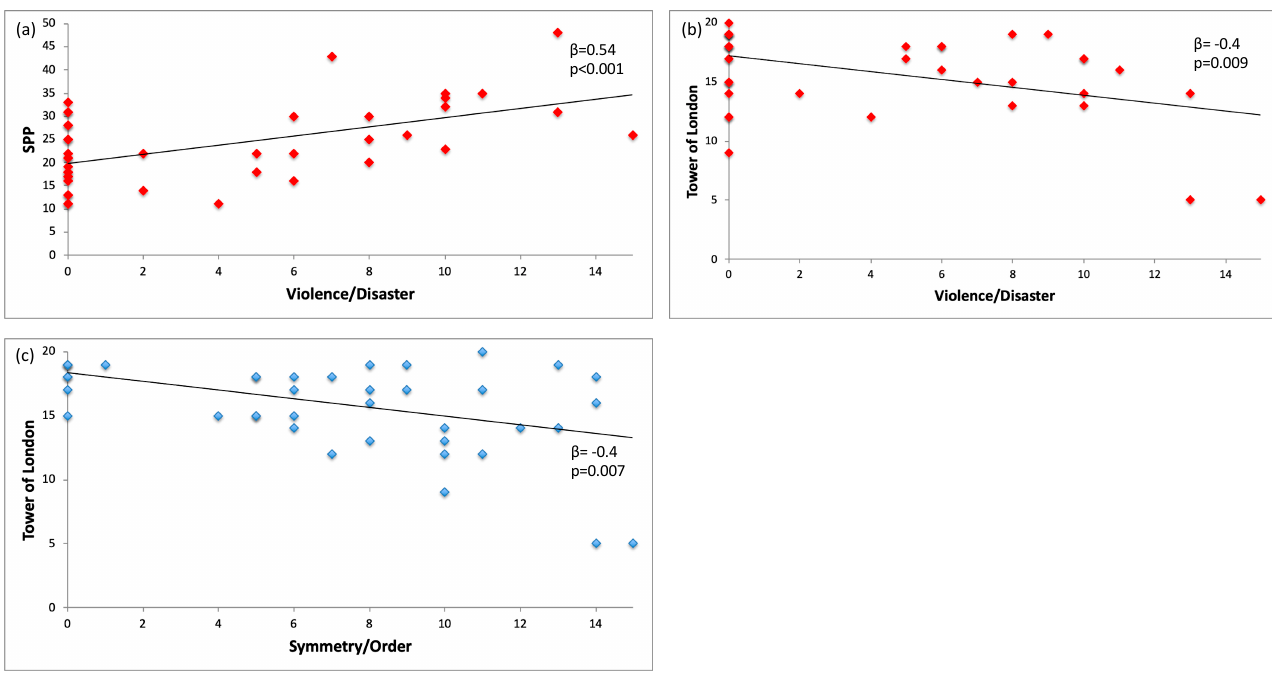
Figure 1. Relationships between OCD dimensions, cognitive and dysfunctional belief measures: ( a ) Violence/Disaster dimension and SPP scores; ( b ) Violence/Disaster dimension and Tower of London total scores; ( c ) Symmetry/Order dimension and Tower of London total scores. Legend: SPP: Socially Prescribed Perfectionism.